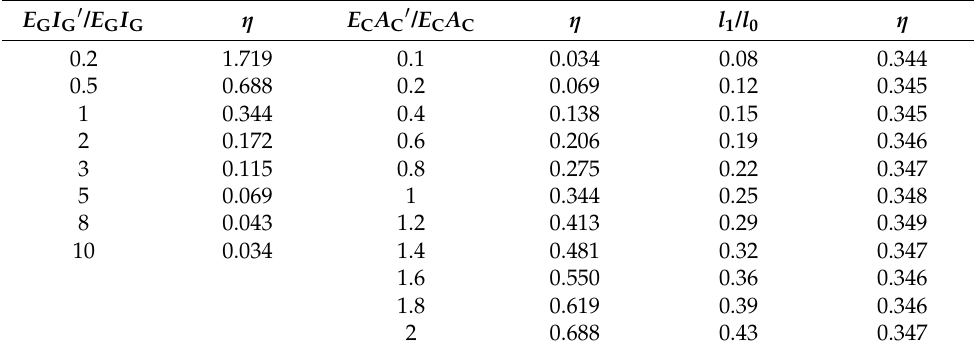
Table 3. Live load ratio of cable girder.